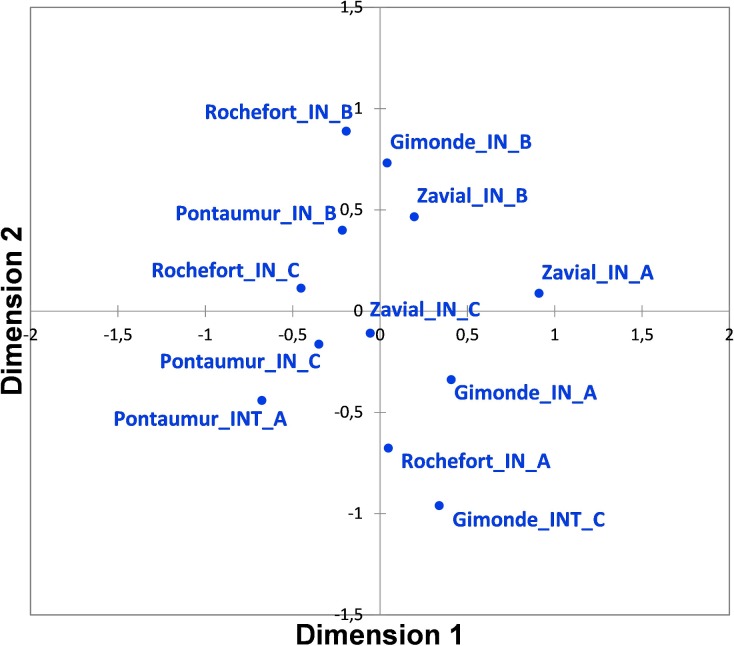
MDS graph resulting of the analysis done with the matrix of dissimilarities (distance measure: Euclidian) for RH levels measured in hives of the four conservation centers over a complete year for each iButton (A, B, C).